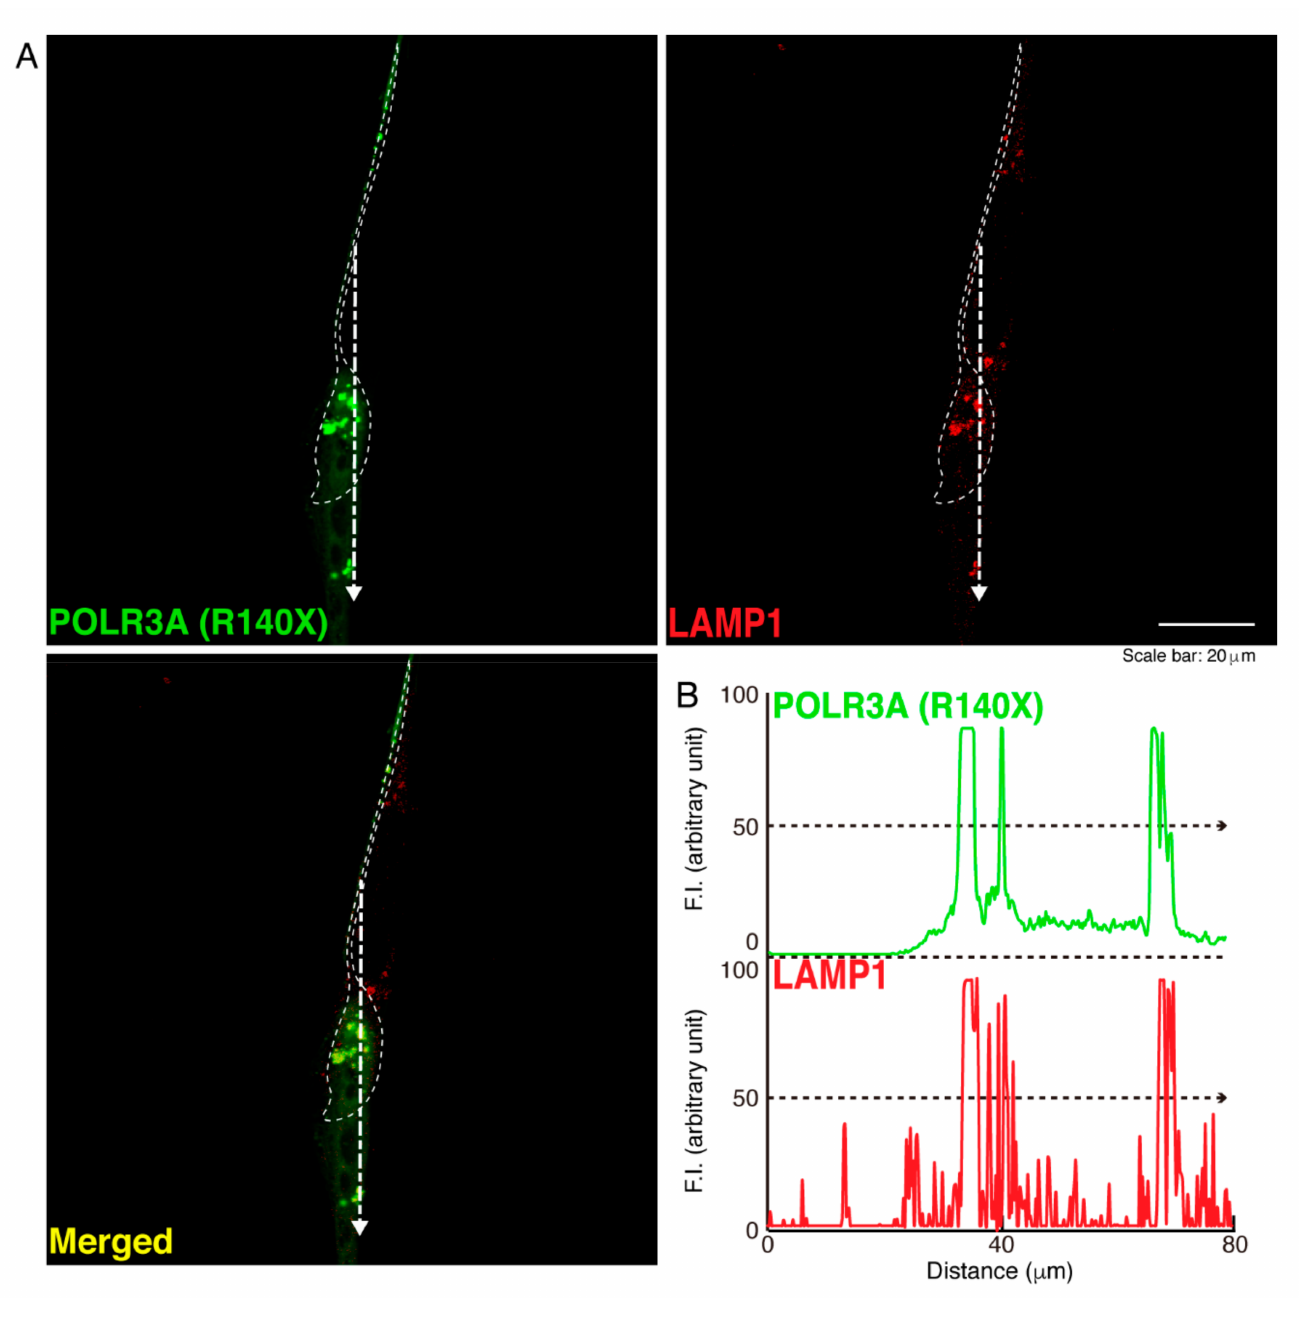
Figure 7. The POLR3A mutant proteins are co-localized with the lysosome in cells. ( A , B ) FBD − 102b cells were transfected with the plasmid encoding the POLR3A R140X construct (green) and stained using an antibody against the LAMP1 antigen (red). Scan plots were performed along the white dotted lines in the direction of the arrows in the color images (green and red as well as merged images). Graphs showing the fluorescence intensities (arbitrary units) along the white dotted lines in the direction of the arrows can be seen in the right bottom panels (black dotted